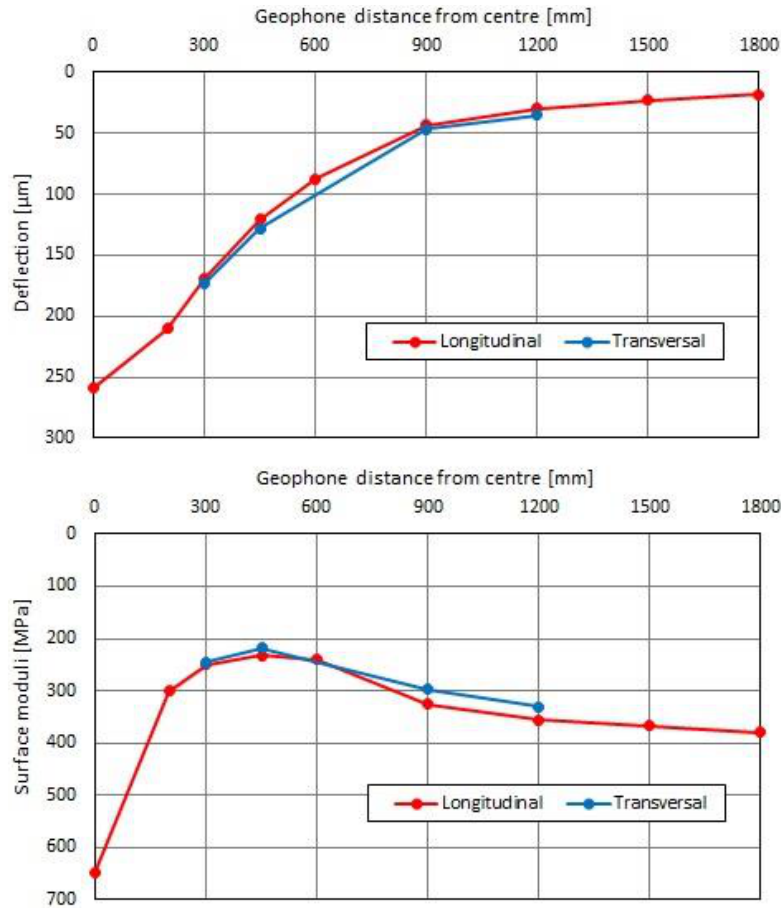
Figure 8. Deflection bowl and values of surface moduli obtained from innovative FWD device.